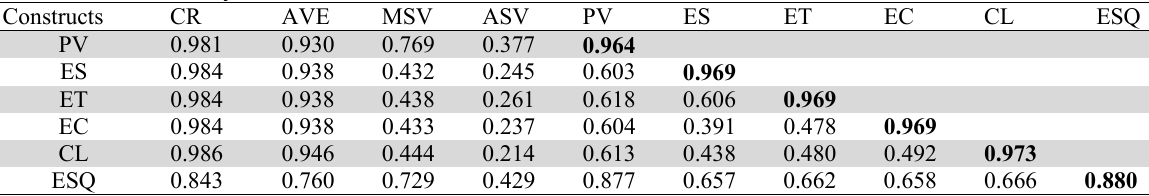
Discriminant Validity for the Measurement